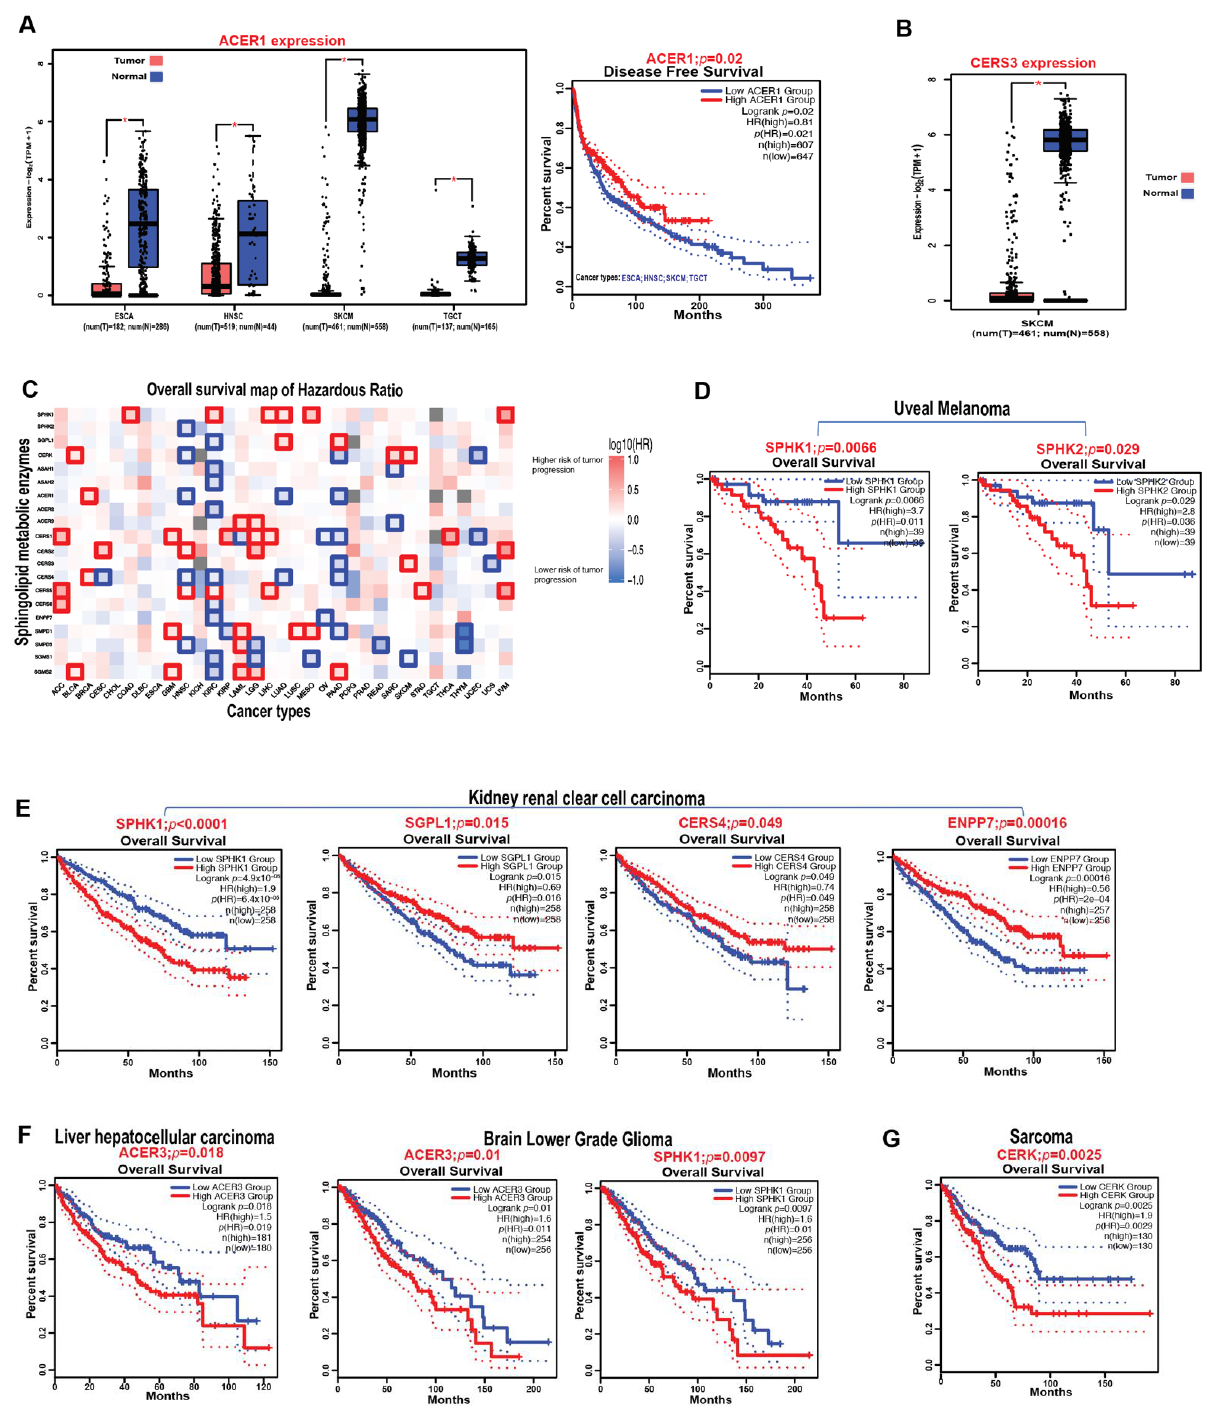
Figure 3. Expression effects of sphingolipid metabolic enzymes on the survival outcomes of cancer patients. ( A ) Box plots indicating the differential expression of ACER1 in ESCA, HNSC, SKCM, and TGCT patients compared to healthy controls. The Kaplan – Meier survival curve shows the overall survival impact of ACER1 expression in ESCA, HNSC, SKCM, and TGCT tumors combined. Tumor group, (T); normal group, (N). * p - Value < 0.05. The differential expression is calculated by the mean